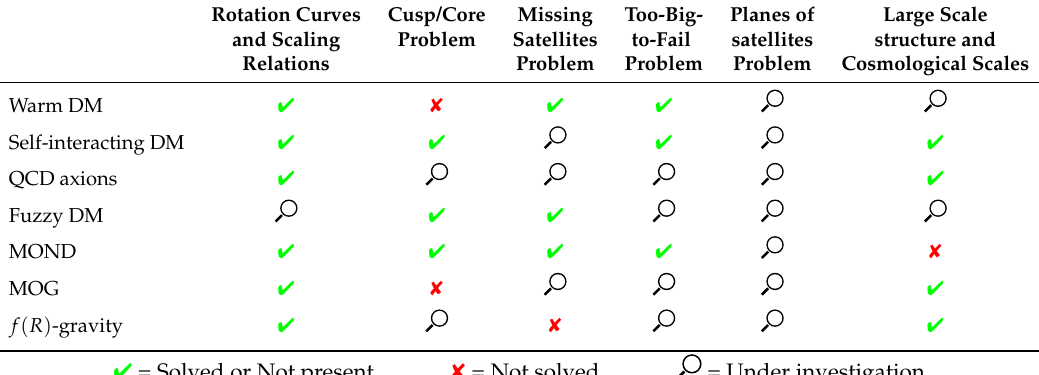
Table 1. Summary of whether alternative dark matter (DM) and gravity models either solve or do not display the challenges of the CDM model discussed in this work. Here, we refer to a problem as “solved” when the model does not currently display major tensions with the observations. The ability of the models to explain the large-scale structure of the Universe is also